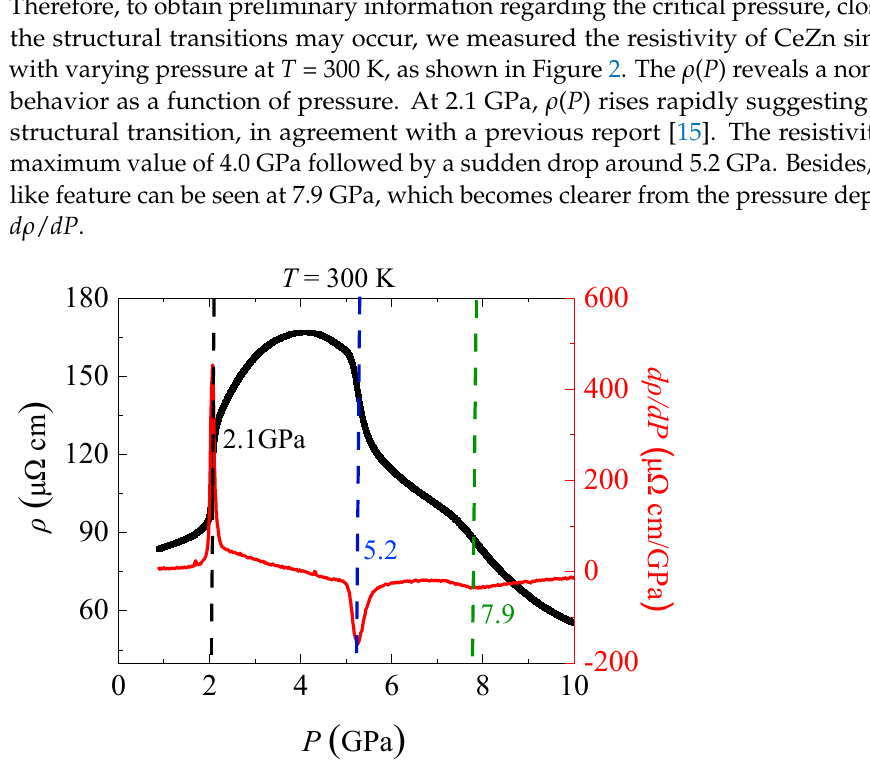
4 of 9 Figure 1. ( a ) Temperature dependence of electrical resistivity ρ , of CeZn single crystal at some se- lected pressures. Black and red arrows show the magnetic transition temperatures, T N and T C , re- spectively. Blue arrow indicates Kondo temperature ( T K ), and green arrows indicate superconduc- tivity transition temperature ( T sc ); ( b ) A zoomed-in view of the low temperature ρ ( T ) for pressure